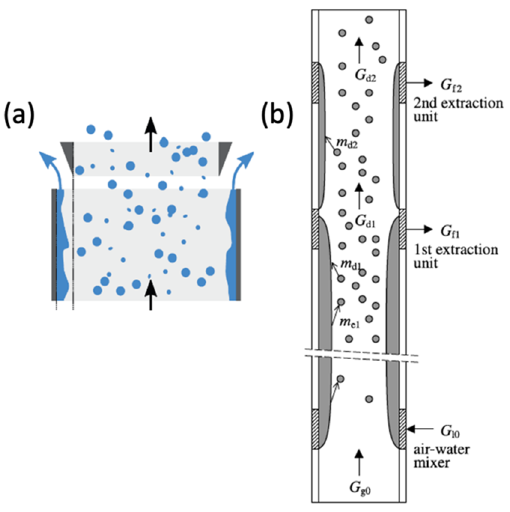
Figure 7. ( a ) , Removal of the liquid film by a circular slit with a wedge-shaped edge, adapted with permission from [47], 2018, Elsevier and ( b ), the extraction of the liquid film by a porous wall for the laser diffraction measurement, adapted with permission from [171], 2005, Elsevier.